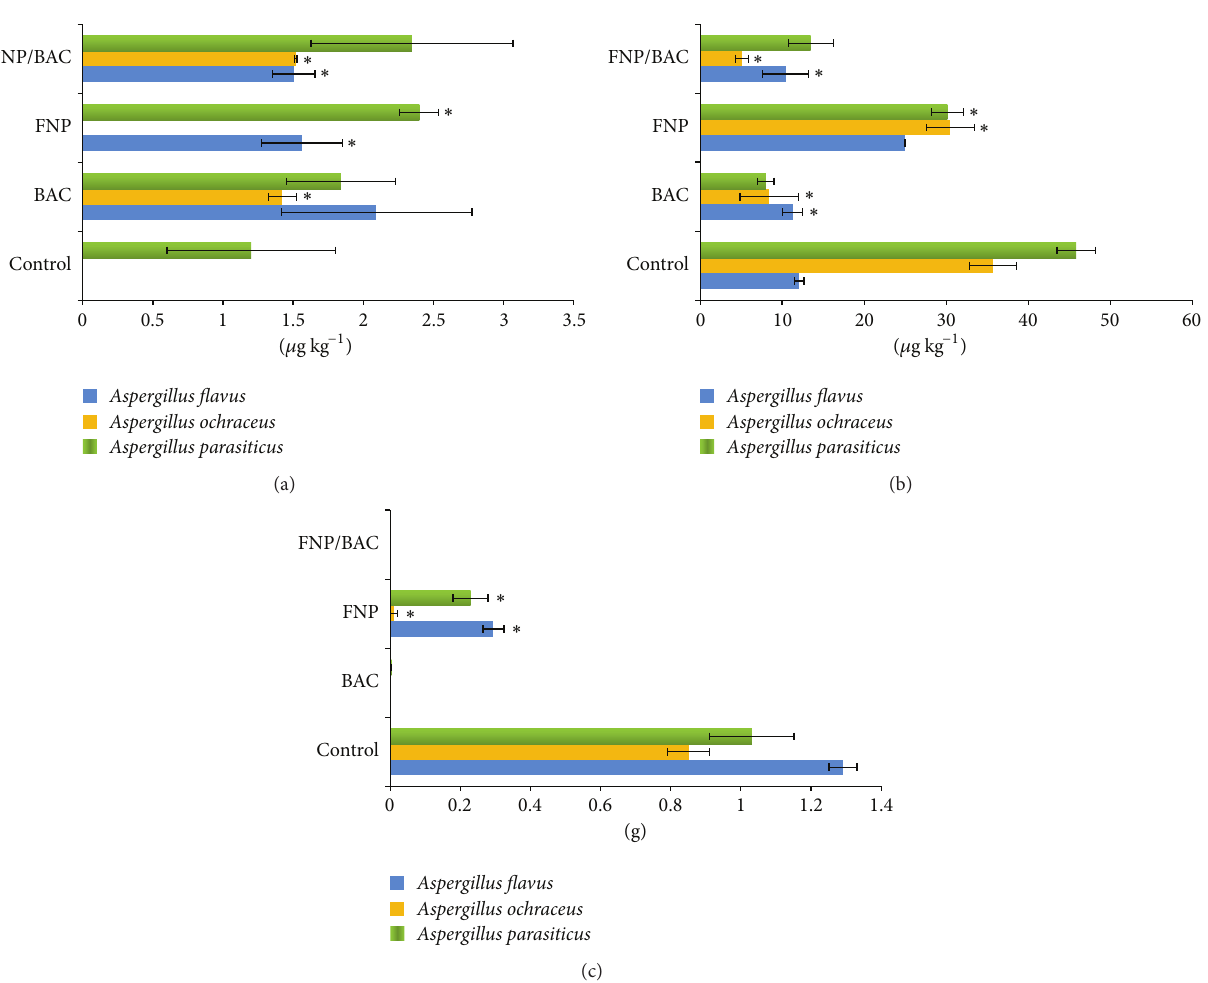
Figure 6: Aflatoxin B1 (a), ochratoxin A (b), and biomass (c) production in toxigenic Aspergillus flavus , Aspergillus ochraceus, and Aspergillus parasiticus culturestreatedwithbiocidebenzalkoniumchloride(BAC),fullerenolnanoparticles(FNP),andfullerenol/benzalkoniumchloride nanocomposite (FNP/BAC). Results are expressed as means ± standard error of values obtained from triplicate experiments ( ∗ 𝑝 < 0.05